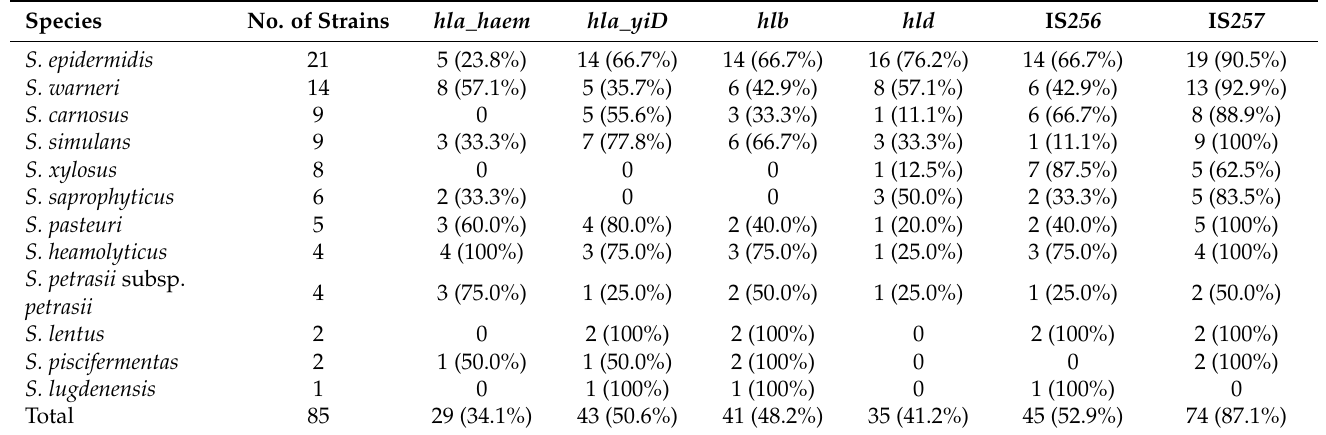
Table 4. Prevalence of the hemolysin encoding genes and the insertion sequences IS 256 and IS 257 among the CoNS.